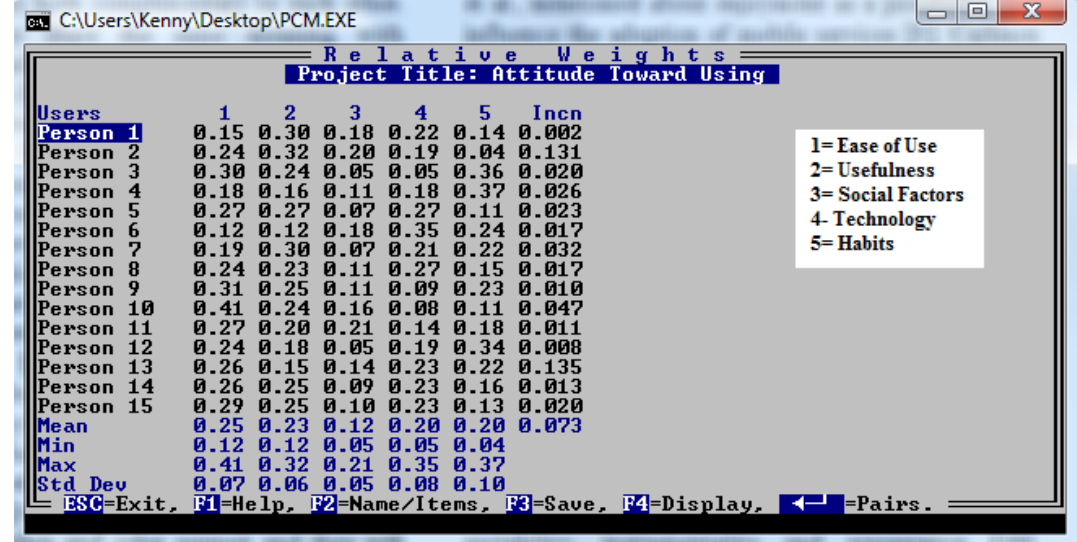
Figure 3. “Main Criteria – Attitude toward Using”.